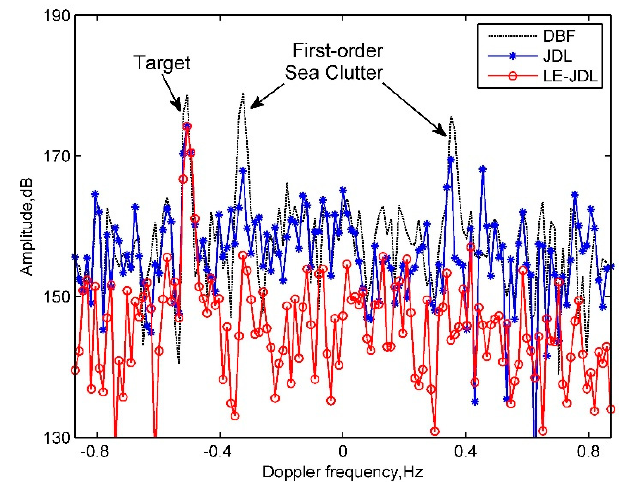
Figure 9. Doppler profile result of DBF method, conventional JDL method and proposed LE-JDL method with non-cooperative target.